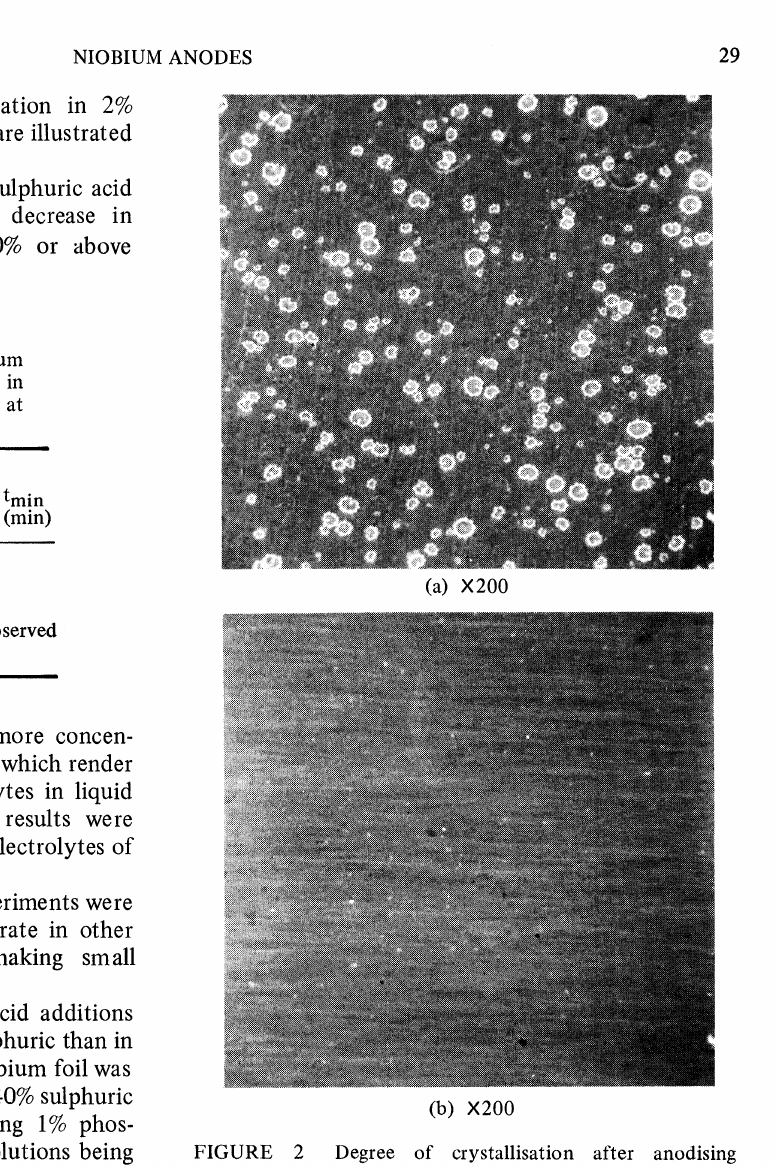
FIGURE 2 Degree of crystallisation after anodising niobium foil in H2SO electrolytes at 50V, 85C, 360 minutes: (a)40% H2SO4, (b)40% HSO4 + 1%